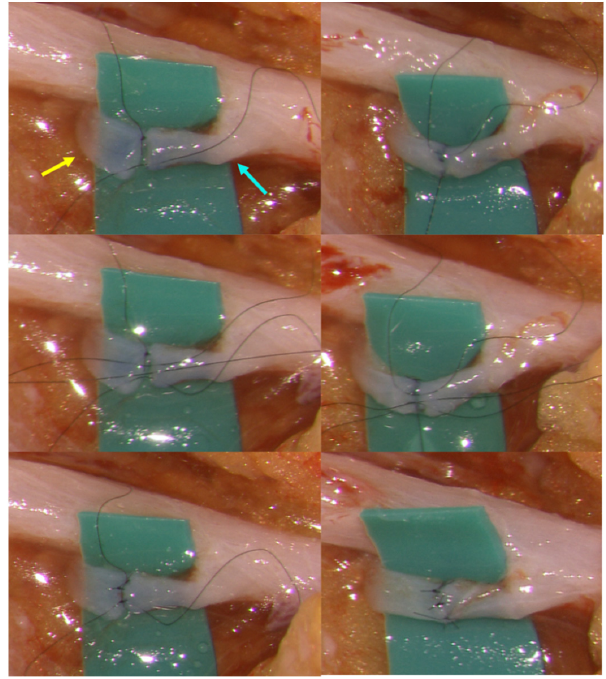
Figure 3. Intraoperative view of lymphaticovenular anastomosis (LVA) with the suture-stent tech- nique: yellow arrow—lymphatic vessel; blue arrow—vein.